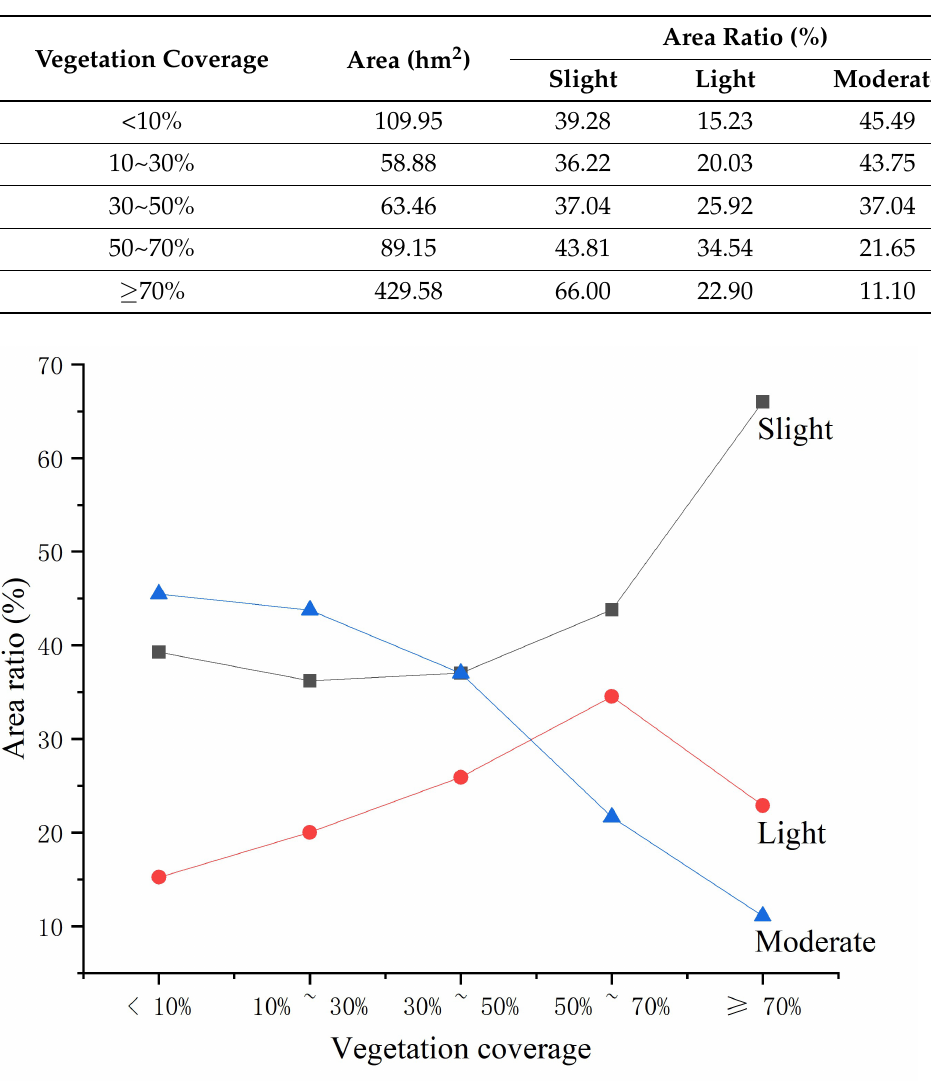
Figure 10. Relationship between vegetation cover and soil erosion